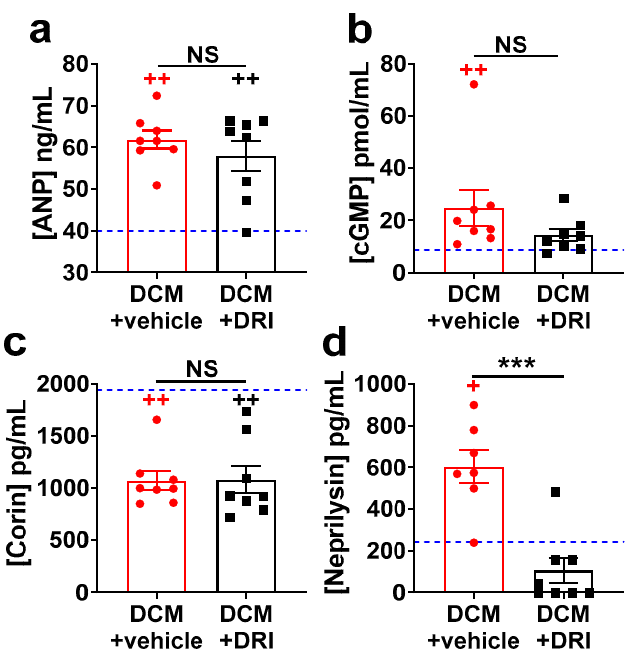
Figure 5. Impact of direct renin inhibitor, aliskiren (DRI-aliskiren) treatment on heart failure plasma biomarkers in female mice with dilated cardiomyopathy. ( a ) Atrial natriuretic peptide (ANP); ( b ) cyclic guanosine monophosphate (cGMP); ( c ) corin; and ( d ) neprilysin plasma levels. DCM + vehicle (red bar) and DRI-aliskiren treated (DCM + DRI, black bar) group numbers are indicated. For reference, values for wild-type (WT) mice are shown as a blue dashed line ( n = 4). Data analyzed with one-way ANOVA and represented as mean ± SE. Not significant (NS), + p < 0.05, ++ p < 0.01 (red, WT vs. DCM + vehicle; black, WT vs. DCM + DRI) and *** p < 0.001 (DCM + vehicle vs. DCM + DRI).